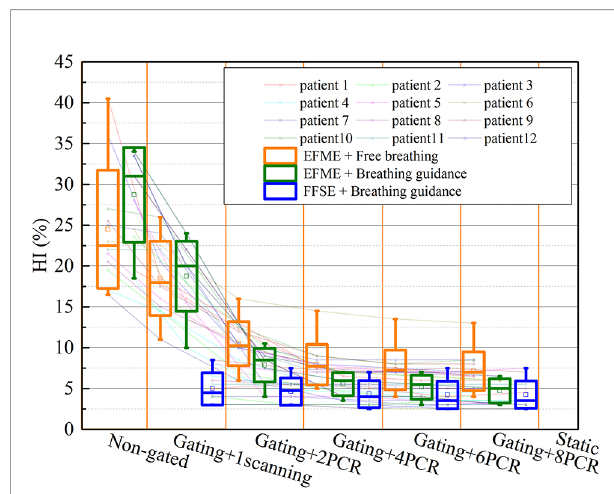
pulses of PCR. However, there were no signi fi cant differences (p >